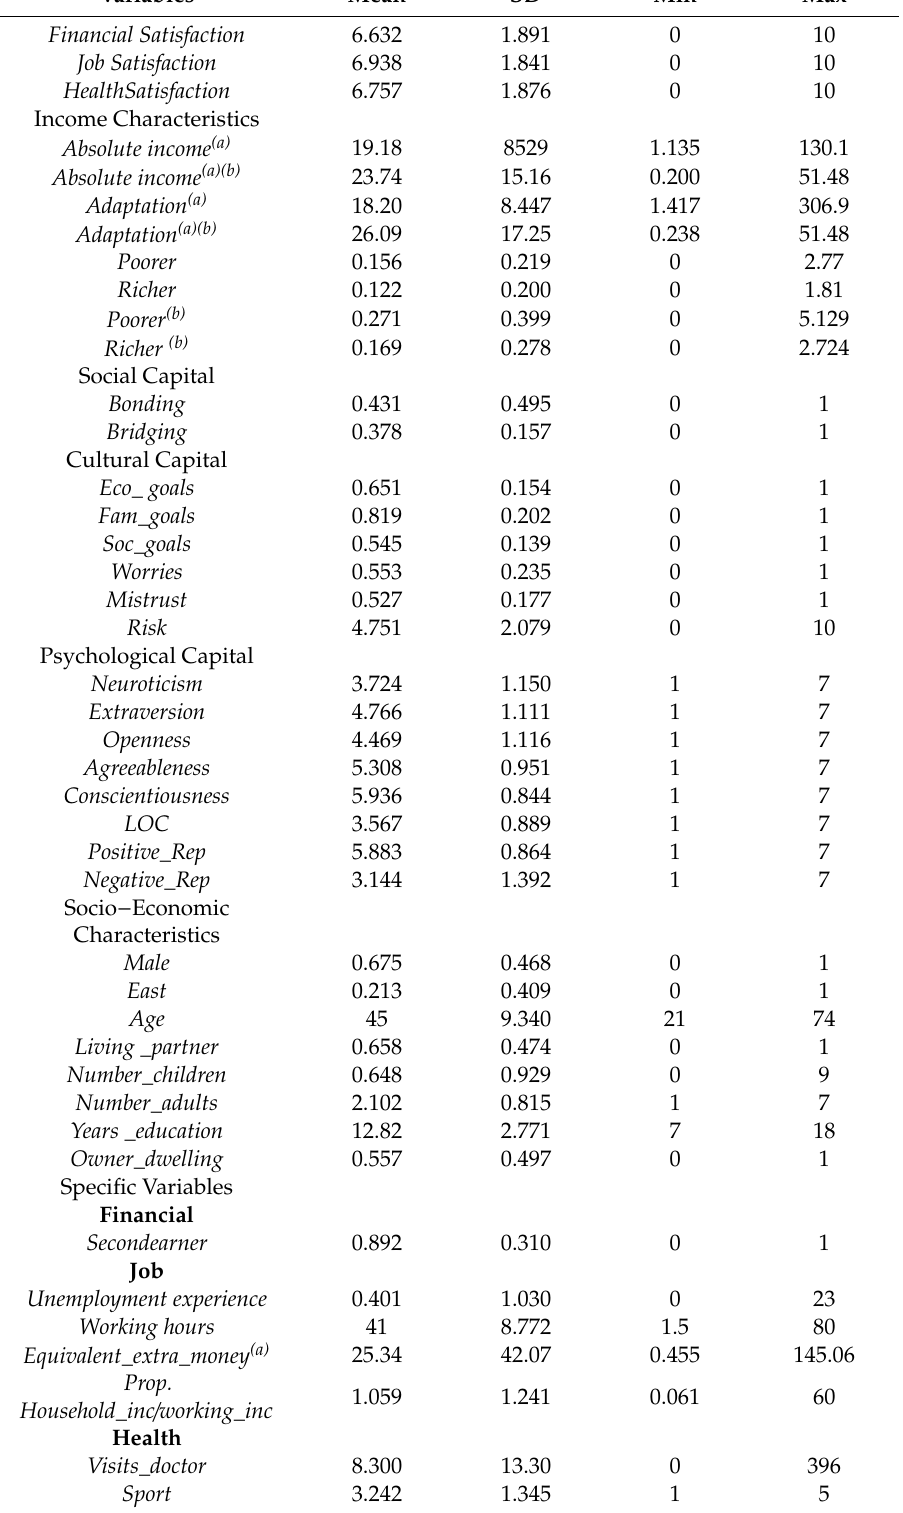
Table 2. Descriptive statistics of domain satisfactions and explanatory